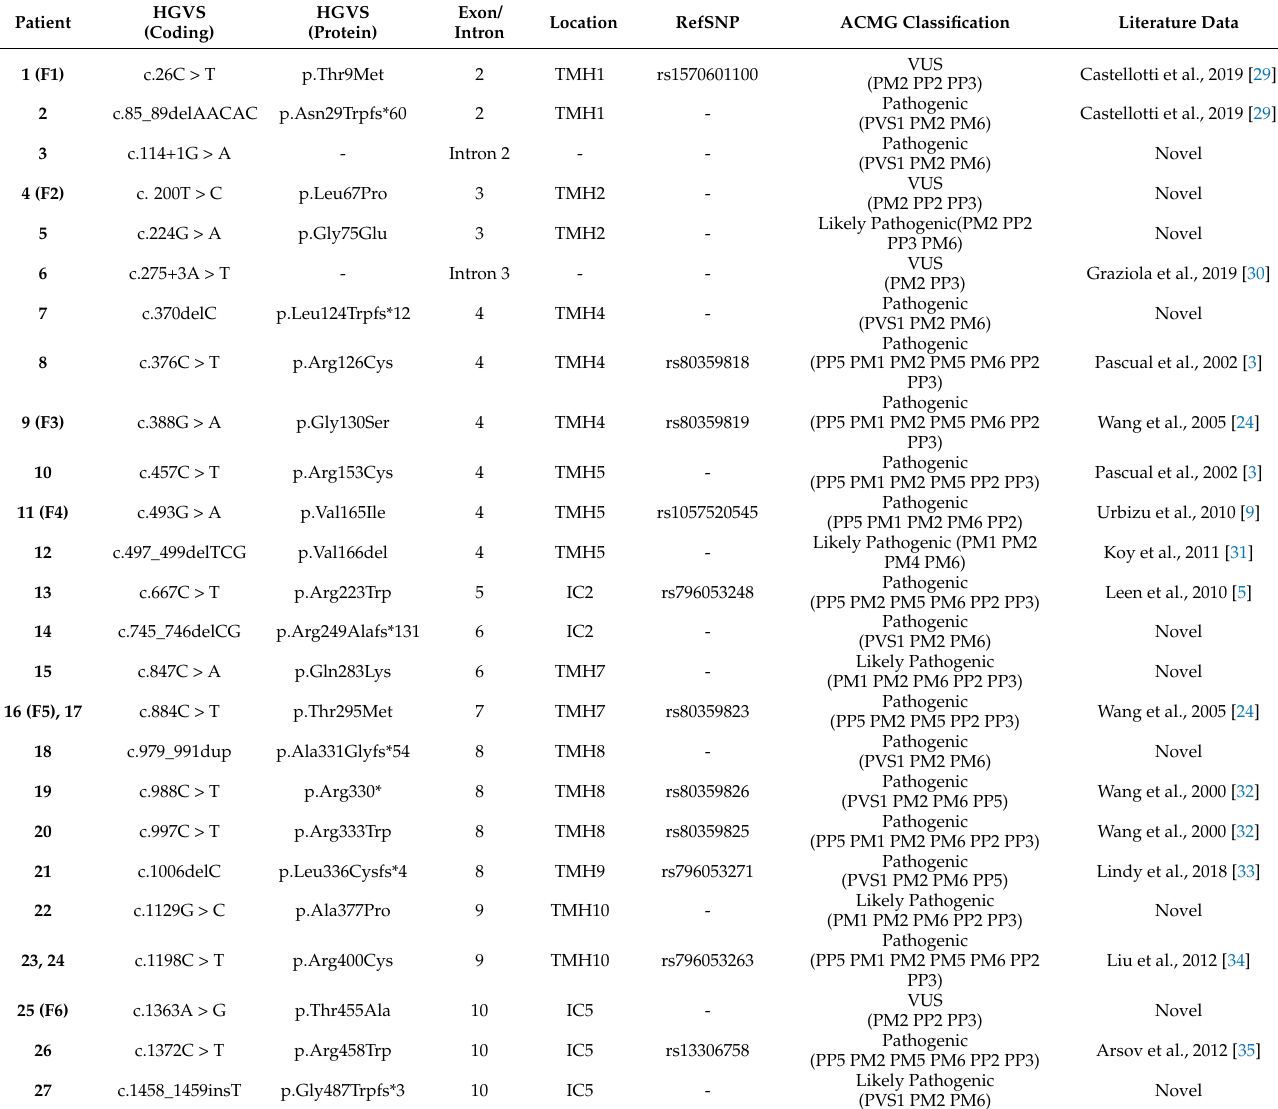
Table 2. SLC2A1 variants identified in 27 GLUT1DS patients with details on HGVS mutation, exon, location, refSNP, ACMG classification and literature reference for variants already